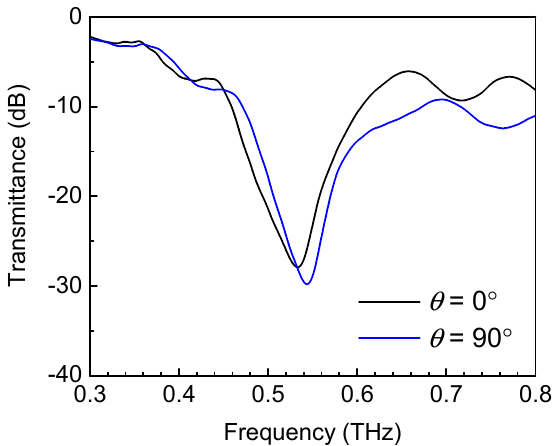
Figure 6. Experimental spectra of metamaterial-coated LC cells filled with E7 LC at θ = 0 ° and 90 ° .